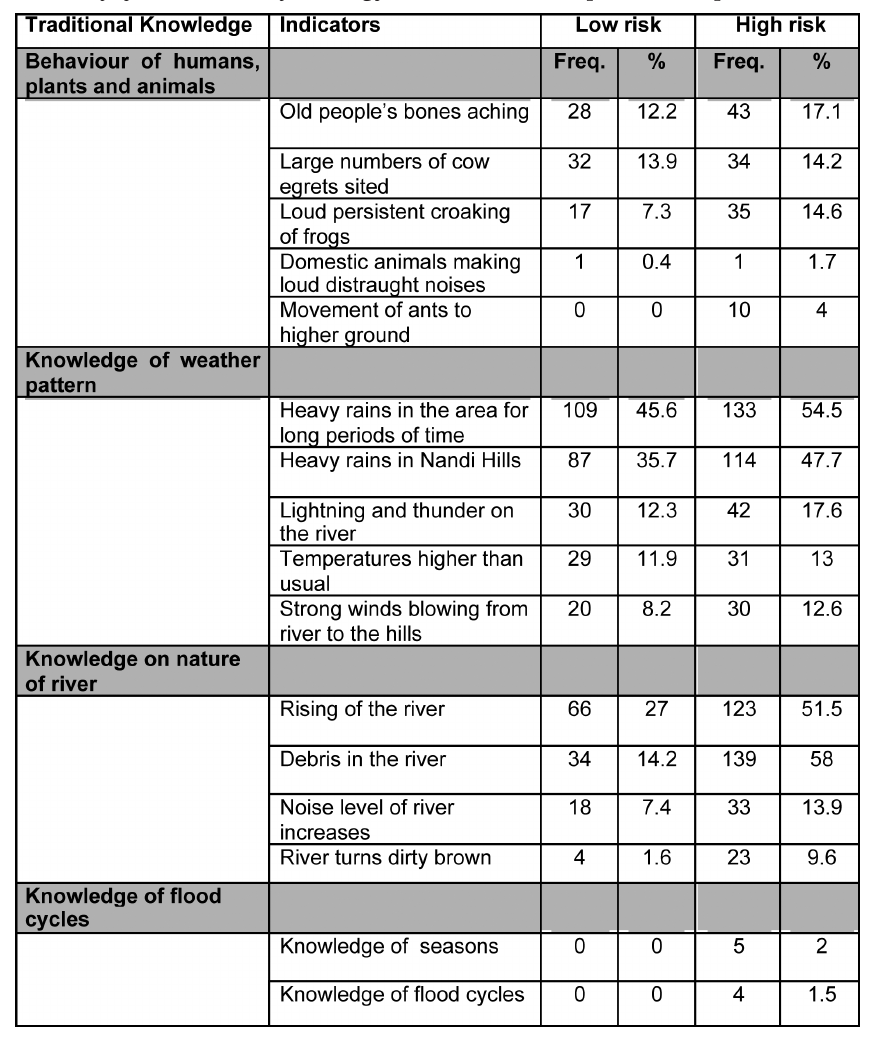
Table 1: Summary of traditional early warning flood indicators ( Multiple answer